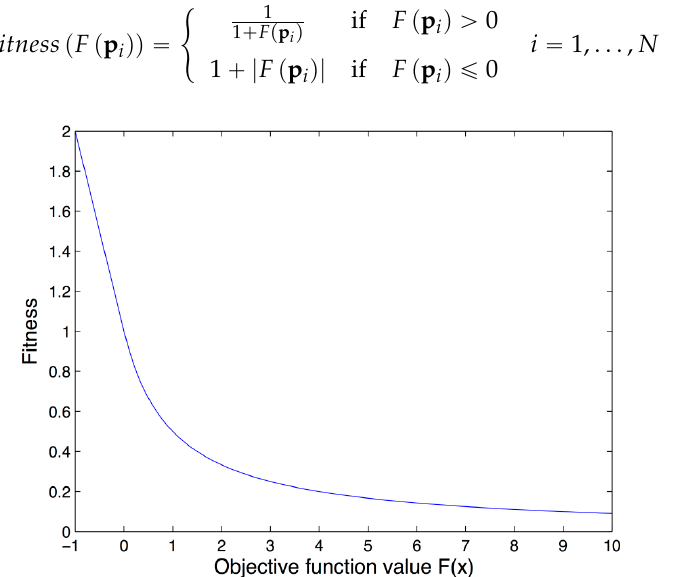
Figure 6. Relation between the fitness of a food source and objective function.